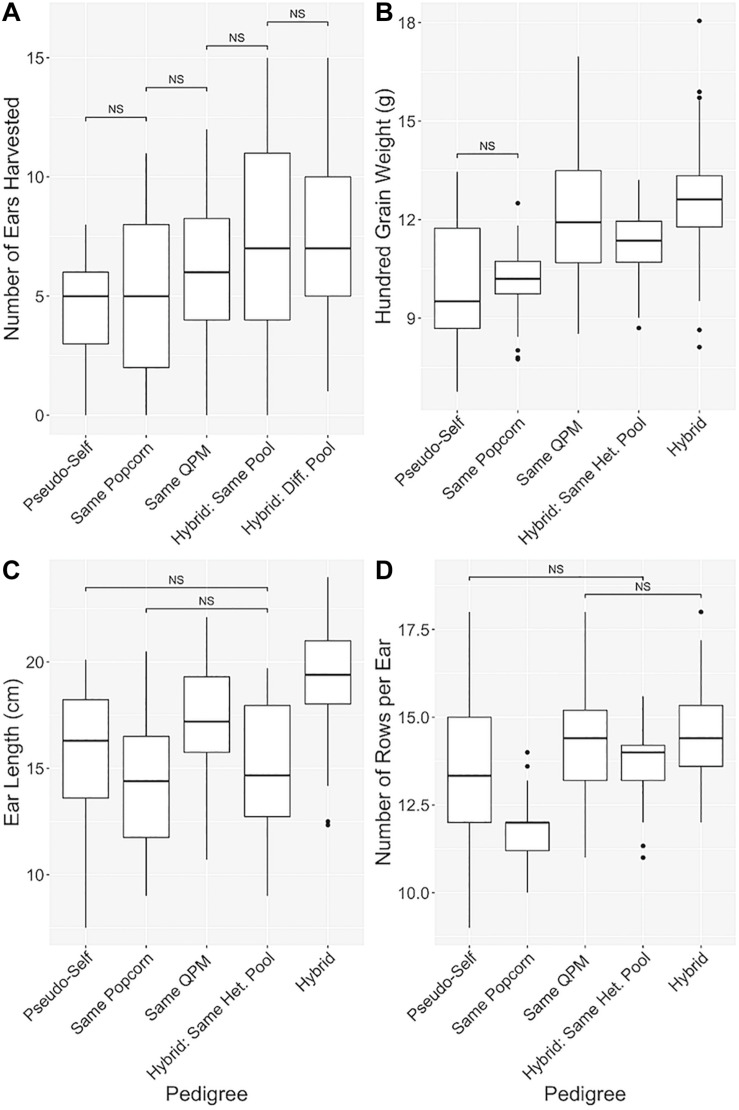
Manifestation of hybrid vigor through pedigree analysis. Pedigree-based categorical grouping of hybrids for agronomic comparison. In order of increasing genetic diversity, hybrids were sorted into “Pseudo-self,” “Same Popcorn,” “Same QPM,” “Hybrid: Same Het. Pool,” and “Hybrid” categories. Traits analyzed were (A) Number of ears harvested per row, (B) 100-grain weight (g), (C) Ear length (cm), and (D) Number of rows per ear. “NS” denoted non-significant comparisons between groups with all other comparisons as significant. Whisker length signify range of values, boxes signify upper and lower quartiles, and the horizontal line denotes average value.